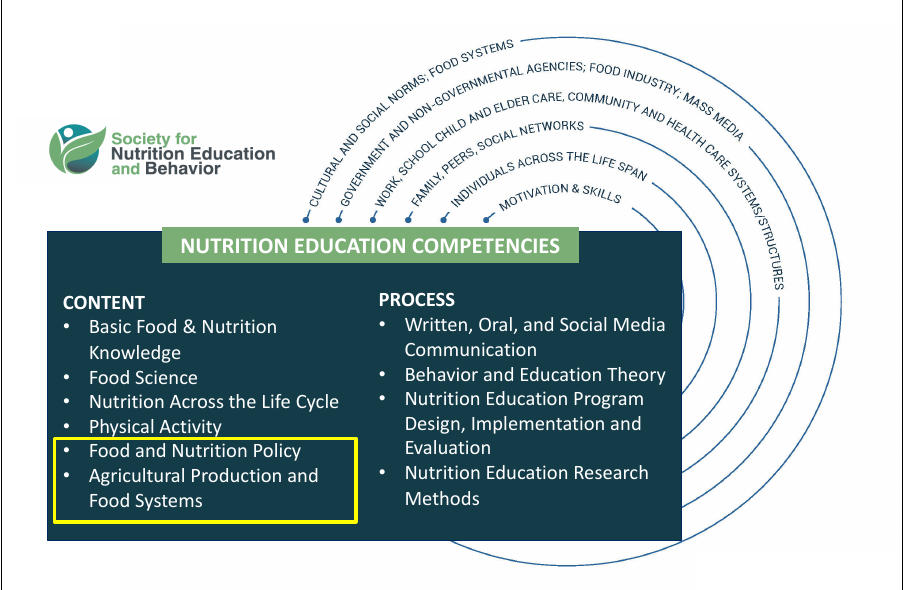
Source: Society for Nutrition Education and Behavior,